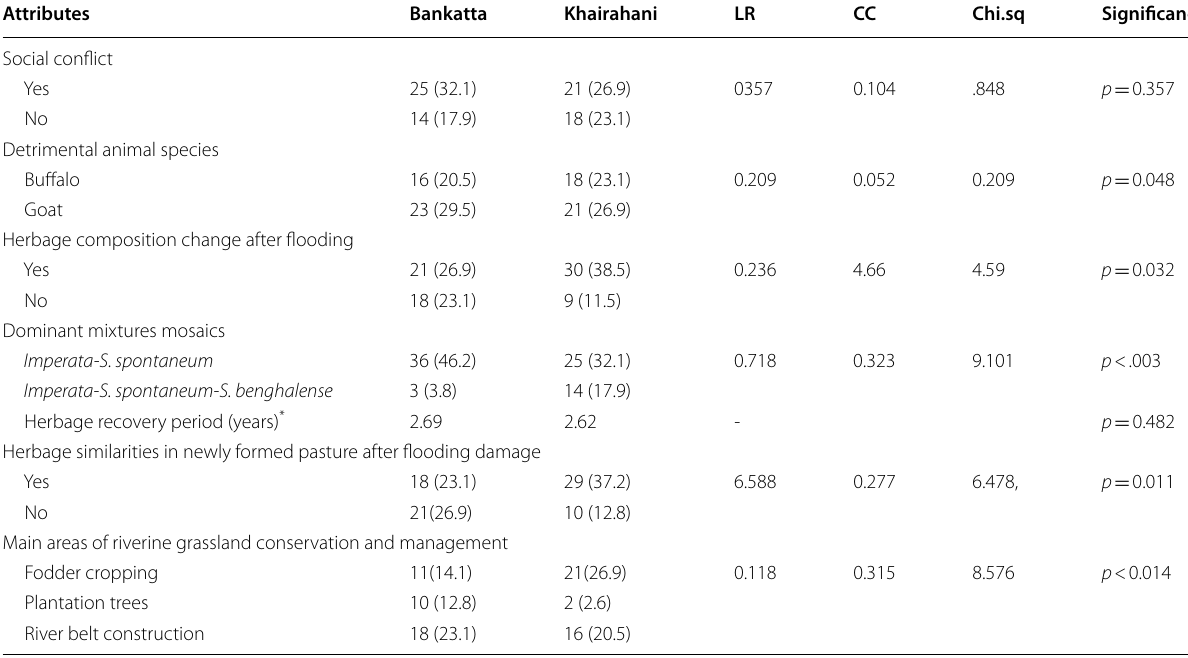
LR likelihood ratio, CC contingency coefficient, values in the parentheses indicated percentage respondents, Chi-sq Pearson chi-square coefficient * Mean analysed by one-way ANOVA, standard deviation =